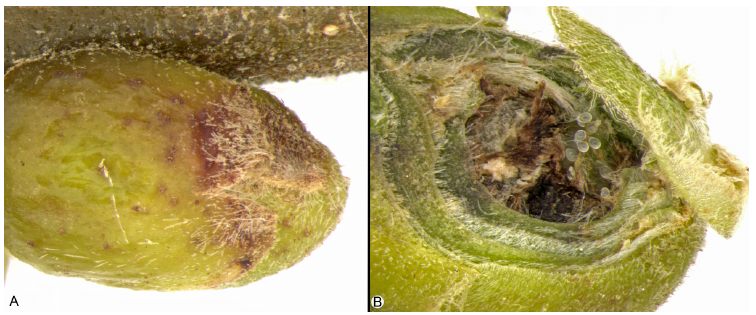
Figure 2. Red salernitan ecotype (RSE) buds after D. kuriphilus attack. ( A ) Scars resulting from the oviposition activity of Asian chestnut gall wasp (ACGW); ( B ) eggs of D. kuriphilus in dissected bud. Table 3. Number of buds with scars, presence of eggs or larvae, and alteration in the internal bud tissues on a sample of 100 buds. Χ 2 contingency table tests.